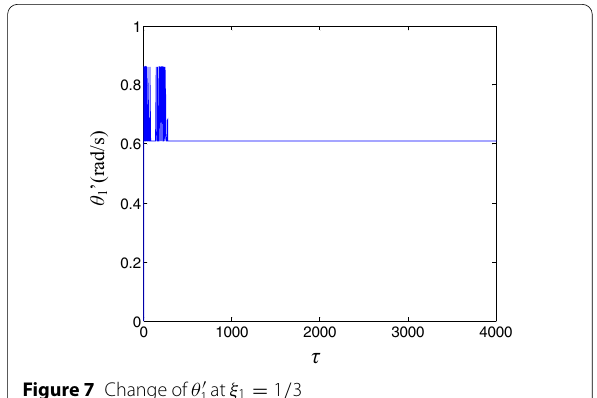
Figure 7 Change of θ ′ 1 at ξ 1 = 1 / 3